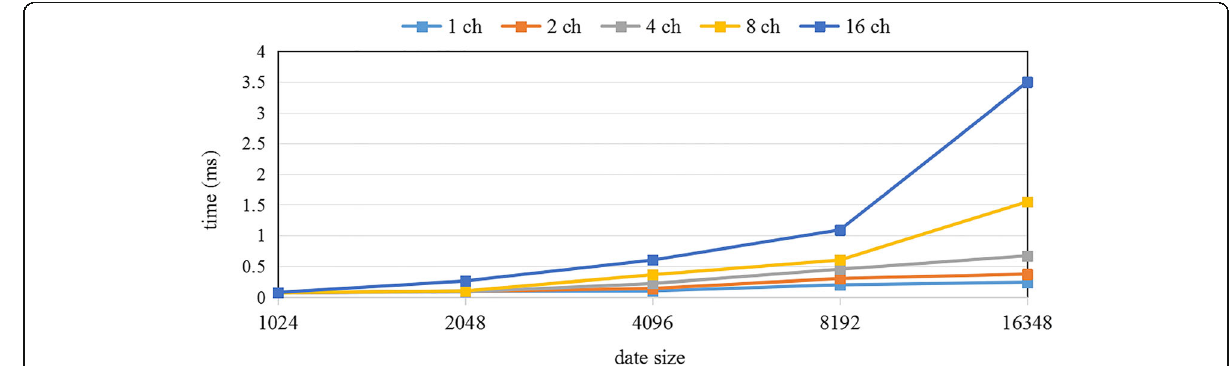
Fig. 9 Time consumed change diagram of FFF operation. The figure shows the time consumed changes in the FFT operation as the number of channels and FFT points changes in the